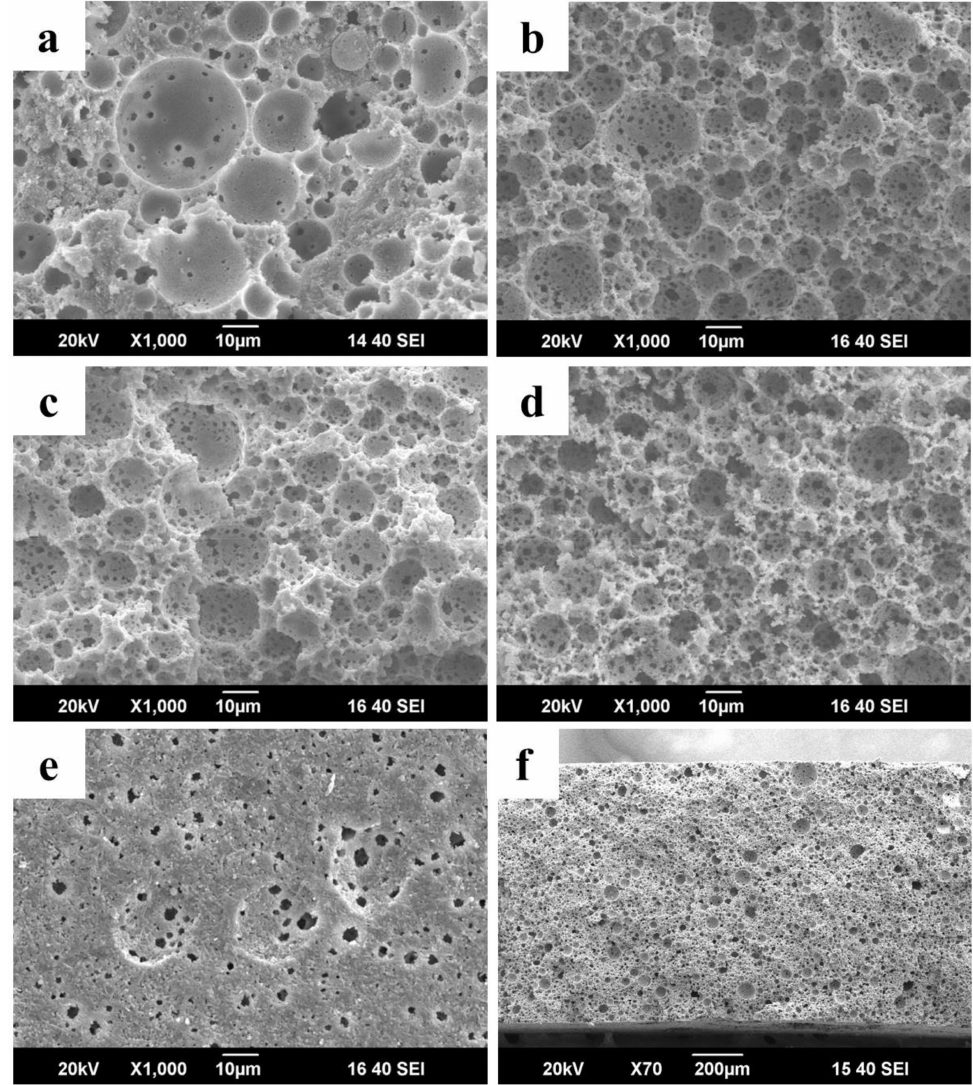
Figure 2. Fracture morphology of the samples with oil–water volume ratio of ( a ) 1:1, ( b ) 2:1, ( c ) 3:1 and ( d ) 4:1, the surface ( e ) and fracture morphology ( f ) of the sample with oil–water volume ratio of